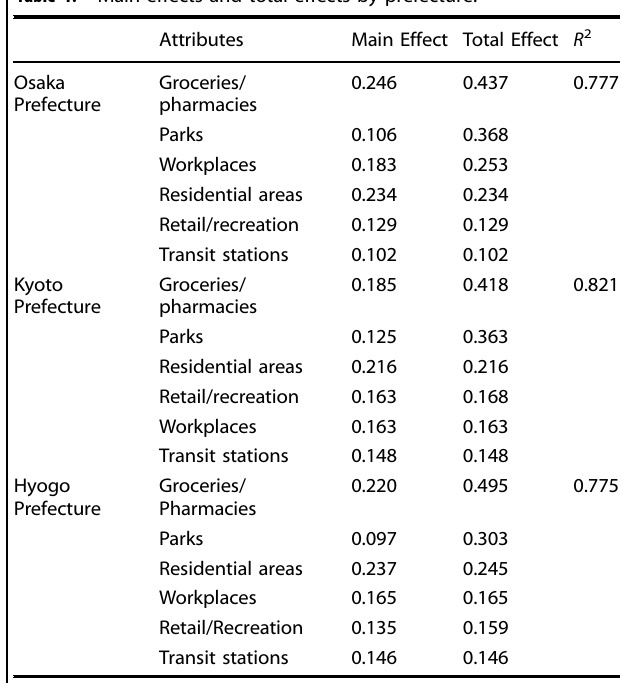
Table 1. Main effects and total effects by